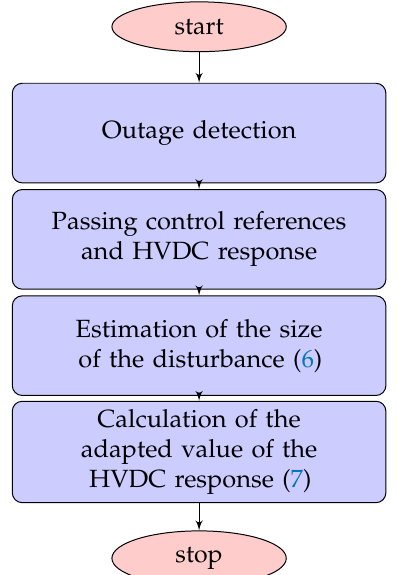
Figure 1. Flow chart of the power system’s response algorithm. HVDC—High-Voltage